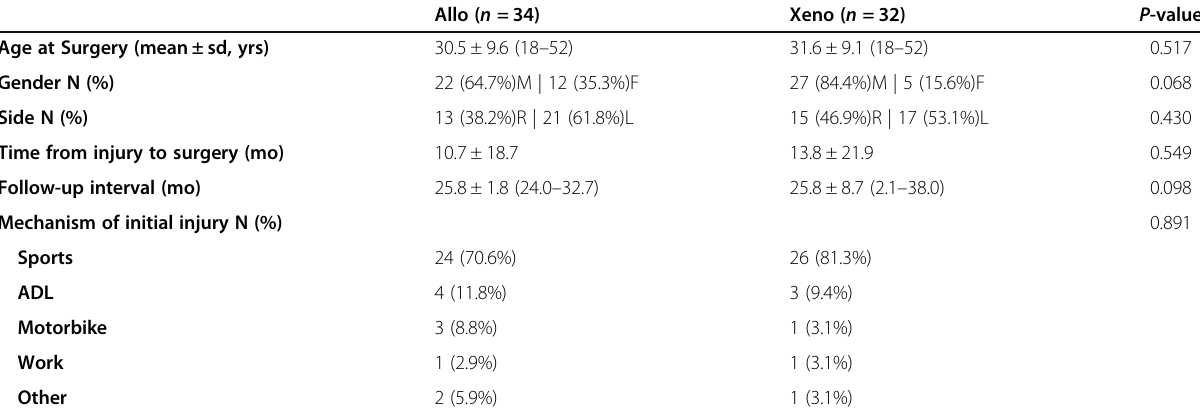
Table 1 Demographic Data and Characteristics of Patients ( N = 66)